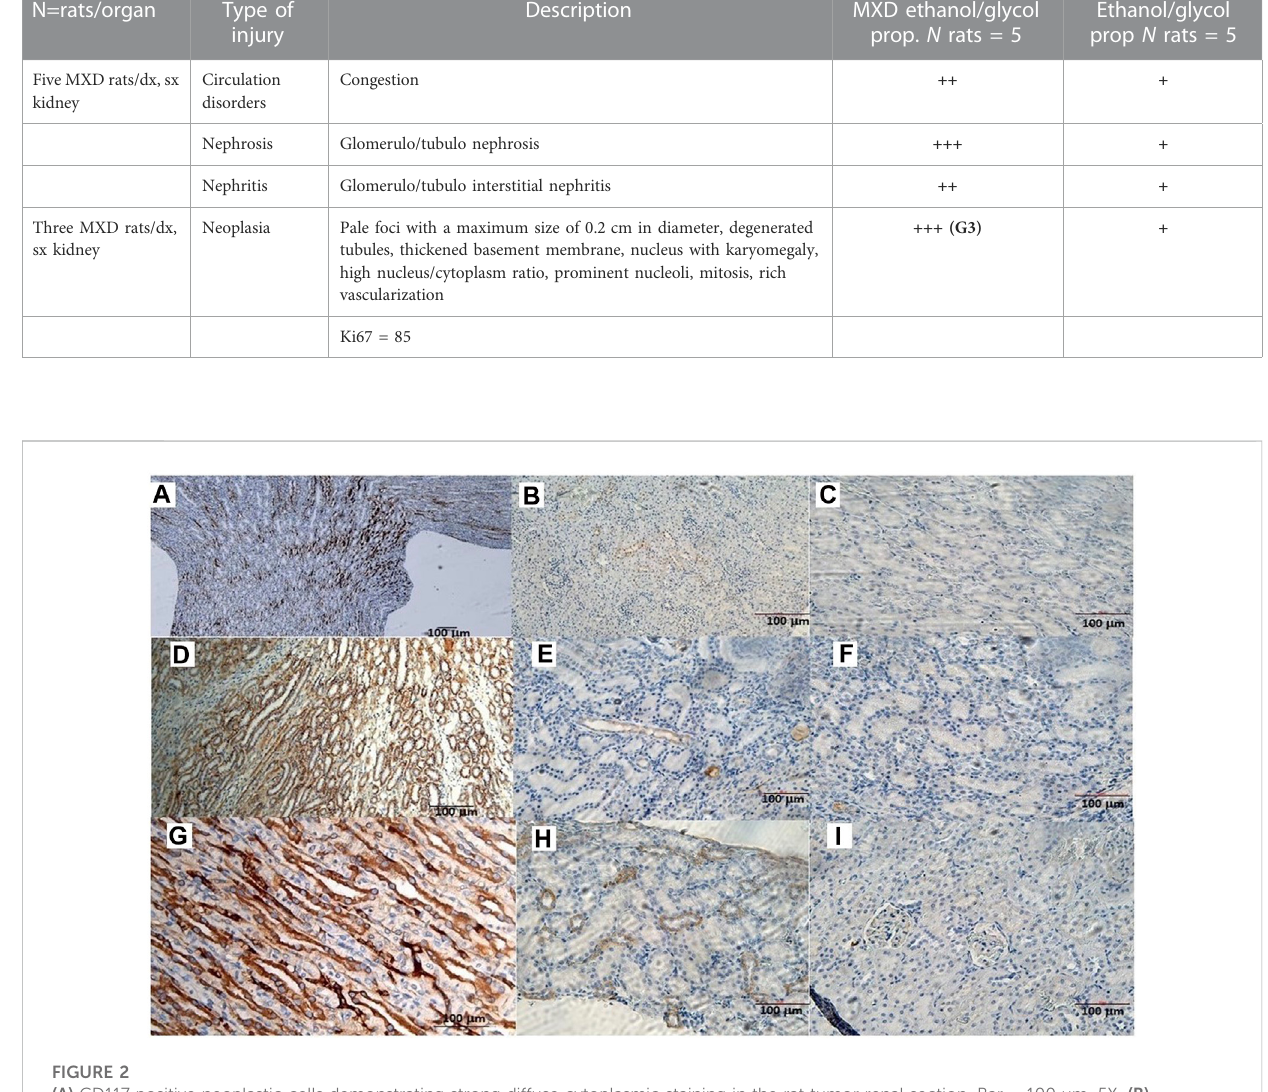
FIGURE 2 (A) CD117 positive neoplastic cells demonstrating strong diffuse cytoplasmic staining in the rat tumor renal section. Bar = 100 μ m, 5X. (B) CD117 reaction in a rat renal section h used as a positive control. Bar = 100 μ m, 10X. (C) CD117 negative control in the absence of mAb anti-CD117. Bar = 100 μ m, 20X. (D) Cell membrane staining positive for the E-cadherin antigen. Bar = 100 μ m, 10X. (E) E-cadherin positive section. Bar = 100 μ m, 20X. (F) E-cadherin negative section. Bar = 100 μ m, 20X. (G) The cytoplasm of the epithelial cells forms tubules positive for cytokeratin antigen